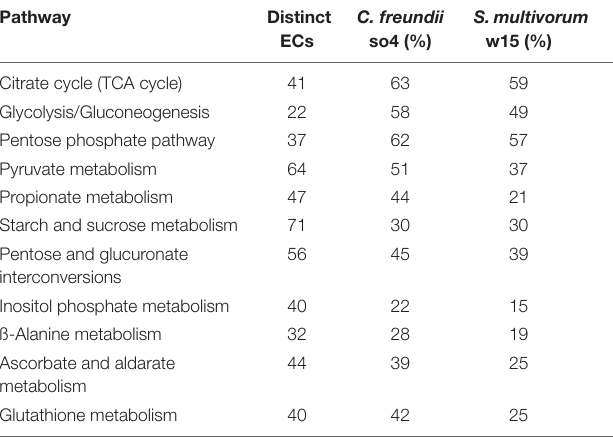
Values represent the percentages of genes/enzymes needed for a functional pathway. Reference metabolic pathway highlighted (KEGG data based). Distinct reactions per metabolic pathway according to the enzyme commission (EC) number. Comparison based on KEGG database. EC numbers do not specify enzymes, but enzyme-catalyzed reactions. If different enzymes, for instance from different organisms, catalyze the same reaction, then they receive the same EC